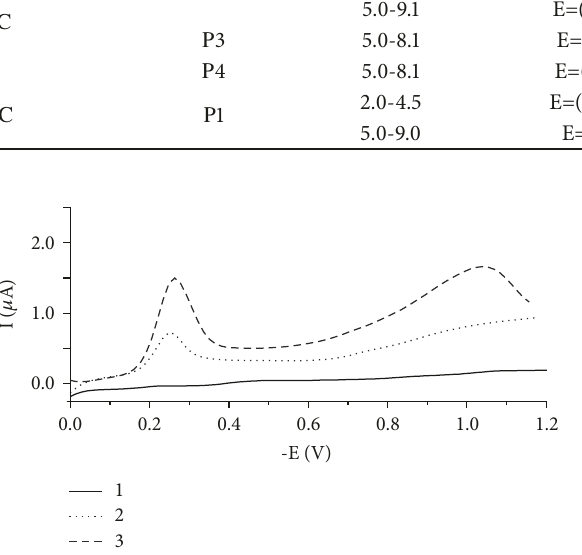
Figure 2: Polarogramms in a PMS solution without BC or PC (1) and the solutions of BC (2) and PC (3) after oxidation at pH 9 and heating to 60 ∘ C. C PMS = 10 −3 mol ⋅ L −1 , C BC = C PC = 5 ⋅ 10 −5 mol ⋅ L −1 . Phosphate buffer was used as supporting electrolyte, b bufer =0.2 mol ⋅ L −1 and a